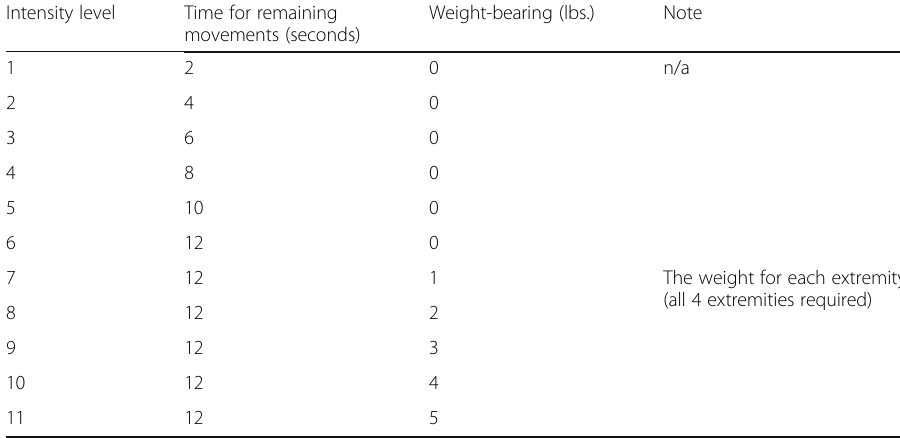
Table 2 The set of intensity levels of the functional fitness training Intensity level Time for remaining Weight-bearing (lbs.) movements (seconds)